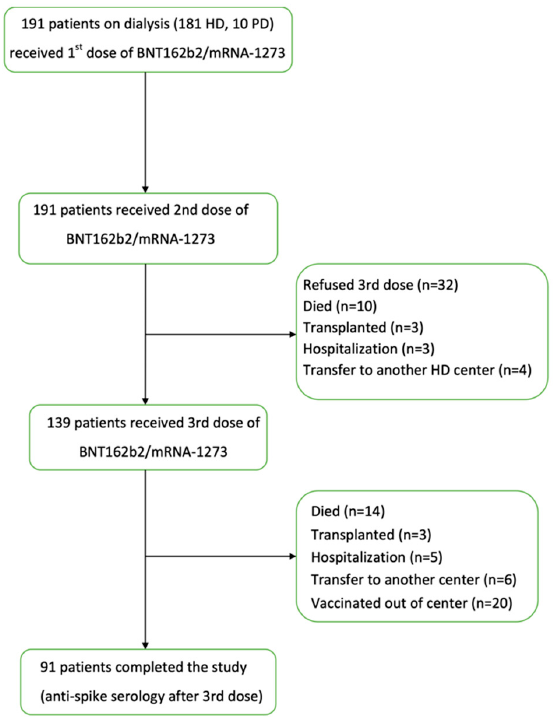
Figure 1. Flow chart of selection of the study population. (HD—hemodialysis, PD—peritoneal dialysis). The characteristics of the patients are presented in Table 1. Table 1. Characteristics of studied population at different time points of study